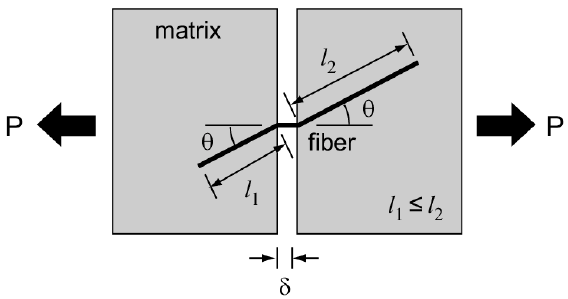
Figure 4. Embedded length of a fiber inclined with θ to the cracked plane.